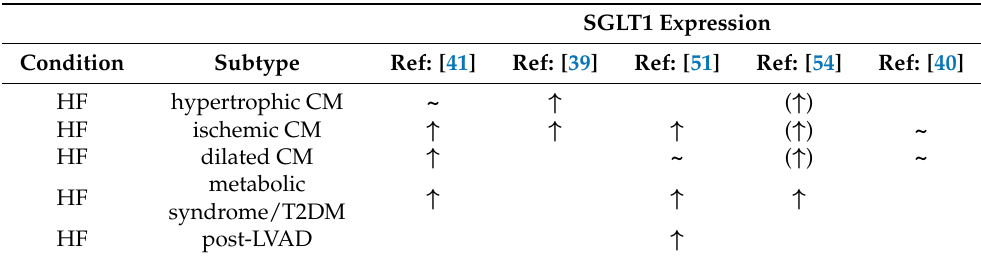
Table 3. Summary of studies in humans investigating the expression of myocardial sodium–glucose cotransporter 1 (SGLT1) in various pathological conditions compared with healthy controls. SGLT1 Expression Condition Subtype Ref: [41] Ref: [39] Ref: [51]